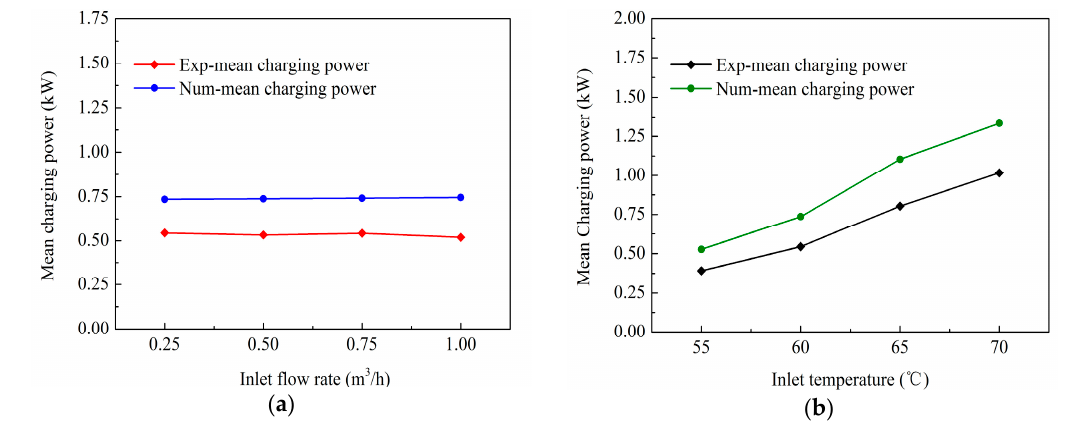
Figure 13. Experimental and numerical mean charging powers for different HTF inlet parameters. ( a ) Constant inlet temperature (60 °C) with variable flow rates; ( b ) Constant inlet flow rate (0.25 m 3 /h) with variable inlet temperatures.